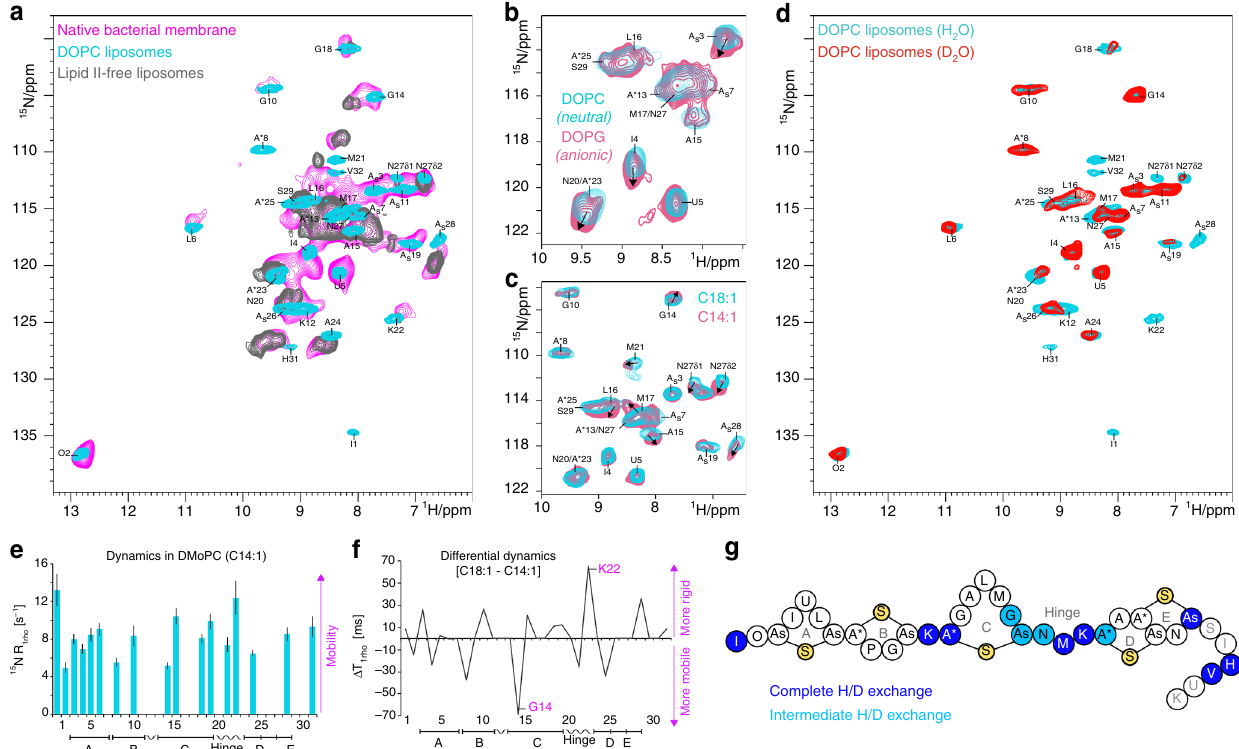
Fig. 2 The lipid II – nisin complex in cellular membranes. a Comparison of 1 H-detected 2D 15 N – 1 H spectra of lipid II-bound nisin in native M. fl avus membranes (magenta) and in DOPC (cyan). The gray spectrum shows nisin non-speci fi cally bound to DOPG:DOPC liposomes (7:3 ratio) in the absence of lipid II. b Overlay of 2D 15 N – 1 H spectra of lipid II-bound nisin acquired in zwitterionic DOPC (cyan) and anionic DOPG:DOPC (7:3 ratio) (pink) liposomes. c Overlay of 2D 15 N – 1 H spectra of lipid II-bound nisin acquired in C18:1 DOPC (cyan) and C14:1 DMoPC (pink) liposomes. d 1 H/ 2 H exchange: 2D 15 N – 1 H spectra of lipid II-bound nisin acquired in DOPC in fully protonated (cyan) and deuterated (red) buffers. e 15 N R 1rho relaxation rates of lipid II-bound nisin acquired in DOPC. The error bars indicate the standard deviation of the fi t. f Differential 15 N T 1rho times comparing dynamics in C18:1 DOPC and C14:1 DMoPC liposomes. g 1 H/ 2 H ssNMR exchange results. Dark and light blue beads represent residues that showed complete and intermediate exchange in deuterated buffers, respectively. Residues S29/I30 and U33/K34 could not be analyzed due to spectral overlap and fast dynamics,